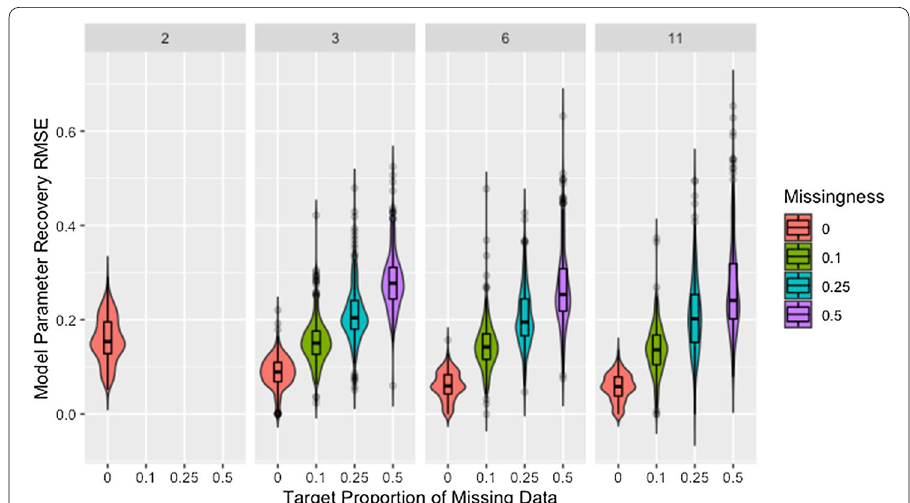
Fig. 7 RMSE for model parameter recovery by missingness and time steps. RMSE for known and predicted weights by proportion of missing data past initial and number of time steps across panels